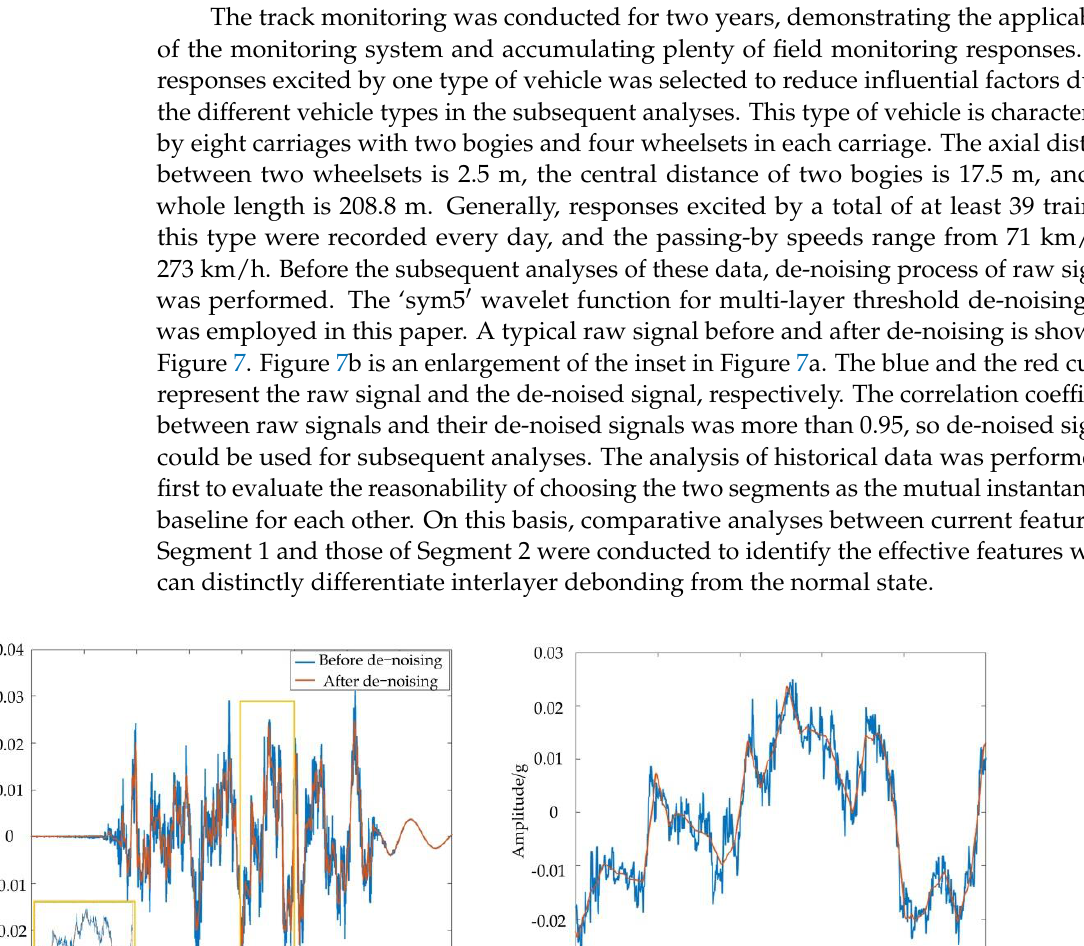
Table 2. Six features of the two segments and their relative differences in the early stage of moni- toring.